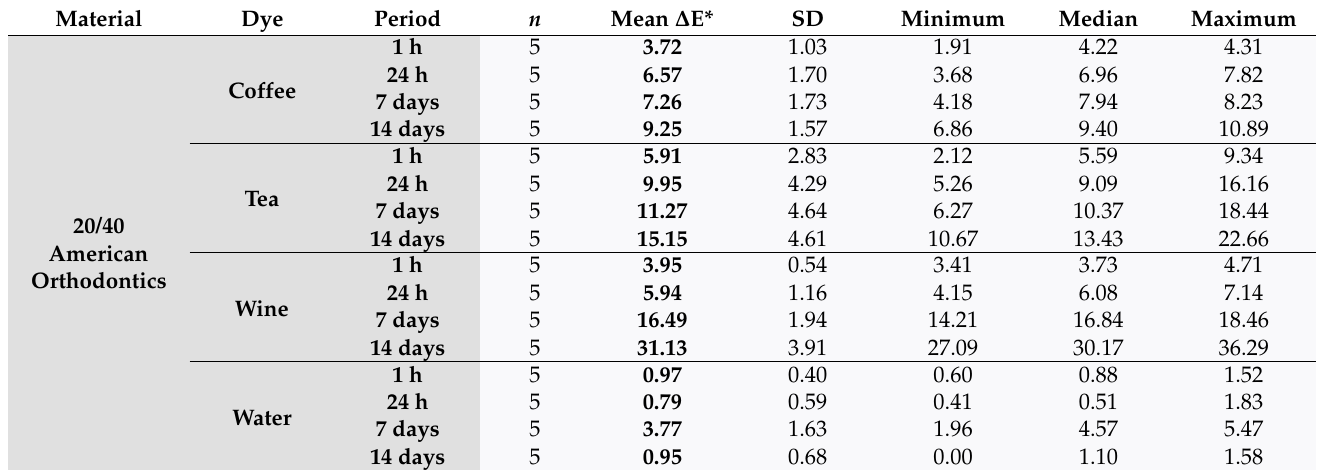
Table 4. Mean color changes of 20/40 brackets with respect to incubation time and type of